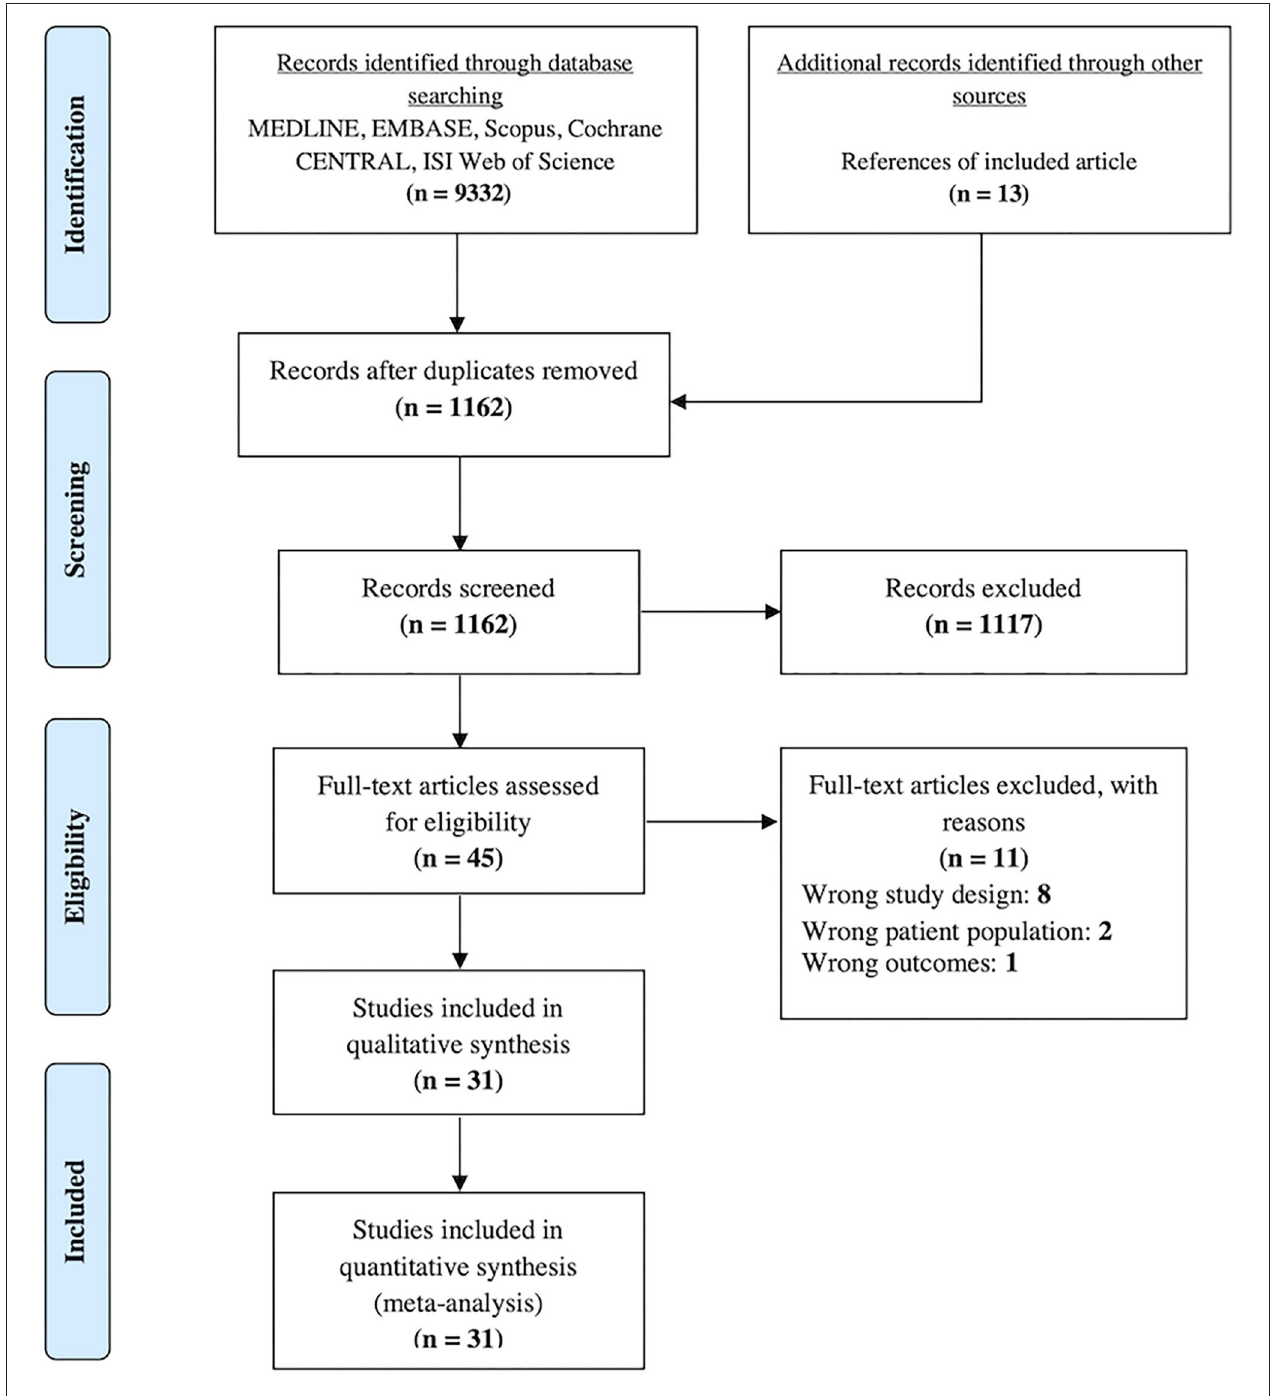
FIGURE 1 | PRISMA flow diagram of the